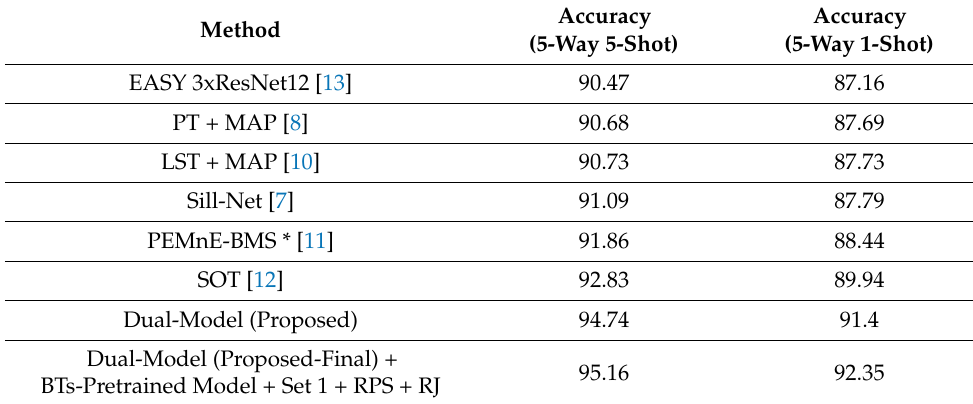
Table 4. Classification accuracy on CIFAR-FS (5-way